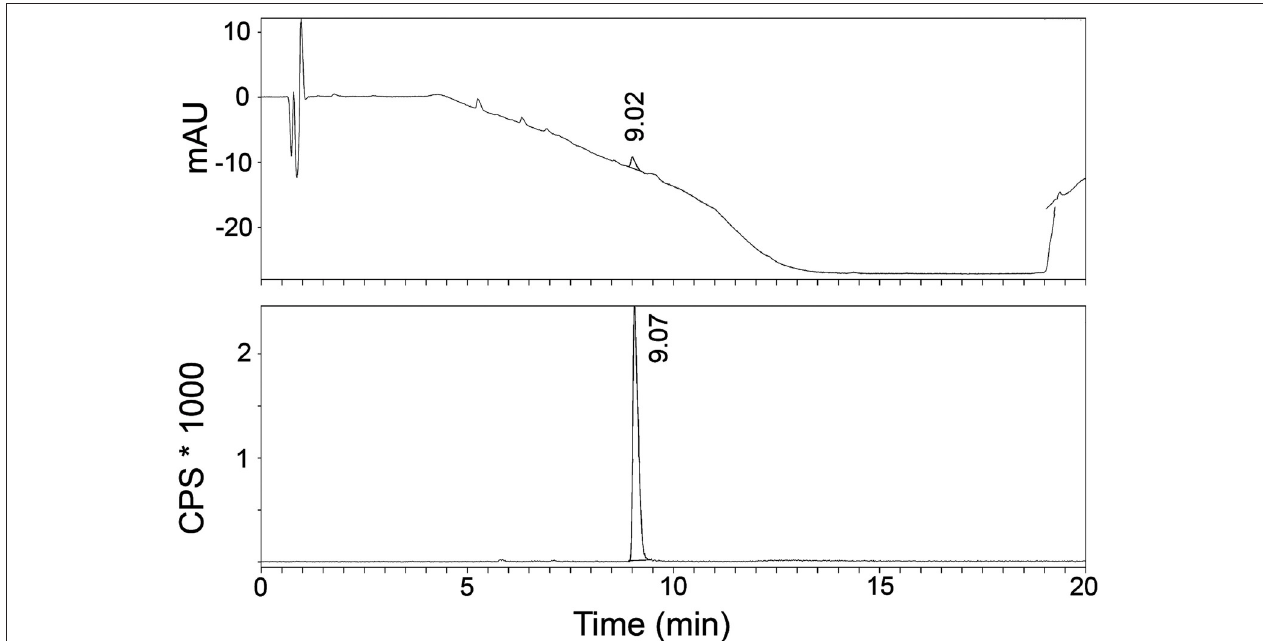
FIGURE 2 | A typical analytical HPLC profile of [ 11 C]AAT-778 [UV-trace (top) and radio-trace (bottom)].